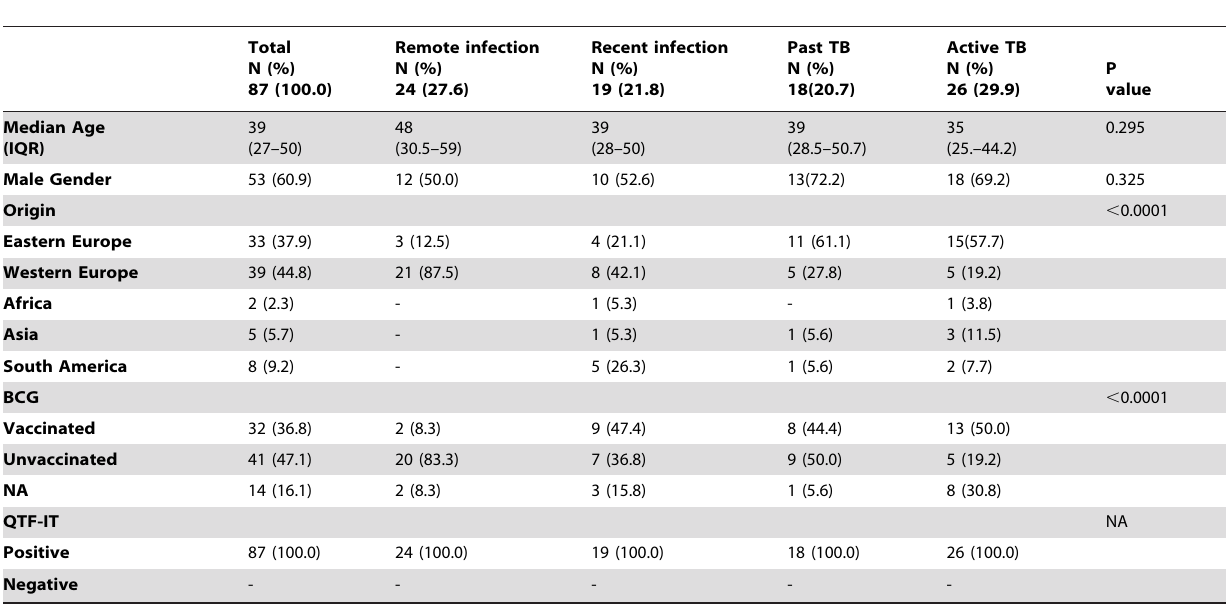
Table 1. Demographic and clinical characteristics of the subjects enrolled in the